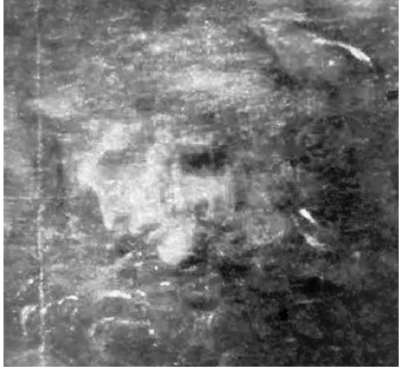
Figure 1. The hidden image of Dante wearing his laurel wreath and young Leonardo as Virgil emerging from the Dark Wood of the Inferno in the background of The Adoration of the Magi . The shadow over Dante’s eye becomes the cave entrance to the City of Woe and its damned inhabitants. Behind them is the Beast. In green cyphers the disguised date 1482 can be